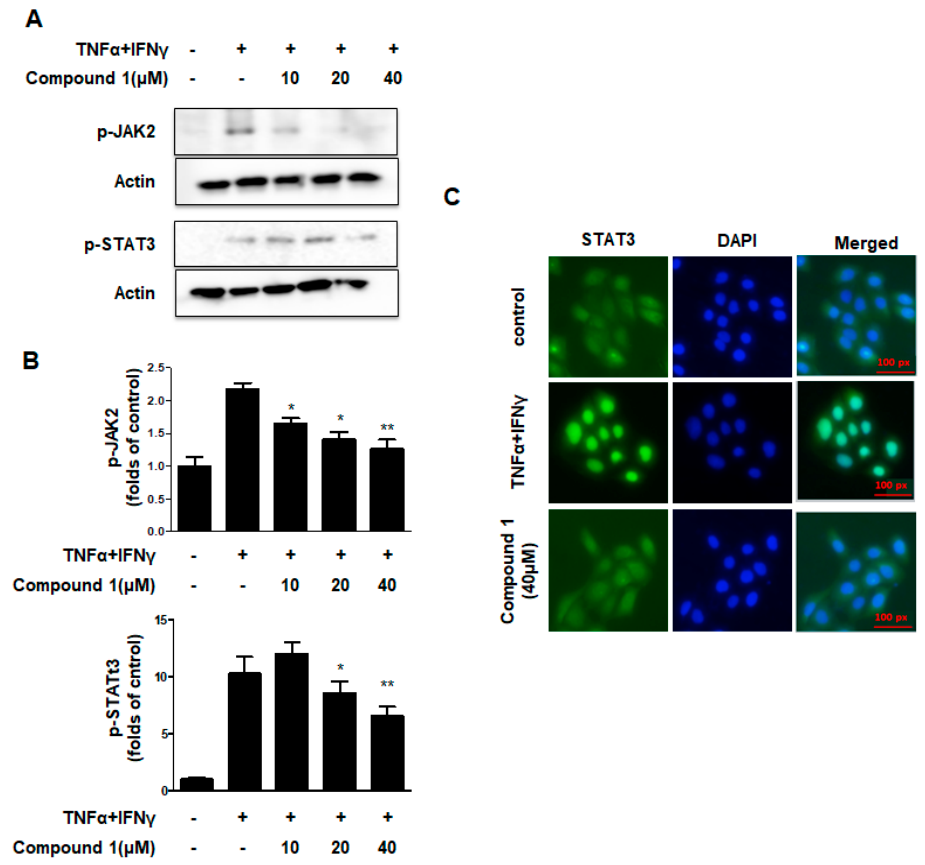
Figure 5. Effects of compound 1 on the JAK2/STAT3 signaling pathways in HaCaT cells. ( A – C ) The expression of p-STAT3 and p-JAK2 were measured using Western blotting. Data are represented as the mean ± SD (n = 3). * p < 0.05, ** p < 0.01 vs. TNF- α /IFN- γ -treated group.